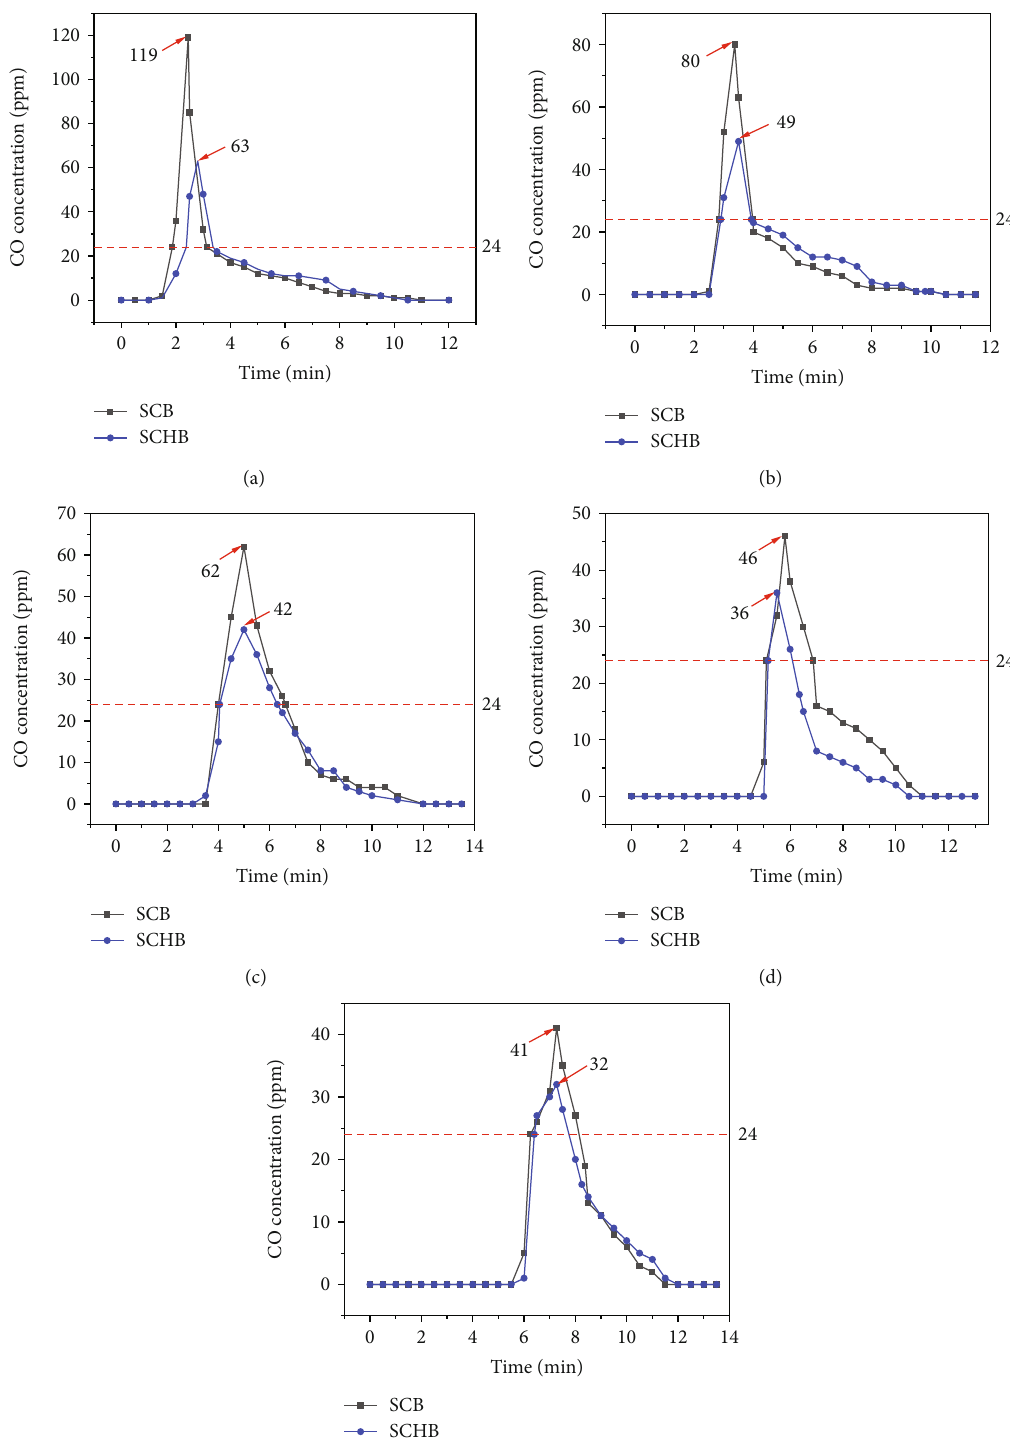
Figure 12: Time-varying curve of CO concentration in single-hole blasting at di ff erent measuring points: (a) 100 m from blasting zone, (b) 200m from blasting zone, (c) 300 m from blasting zone, (d) 400m from blasting zone, and (f) 500m from blasting